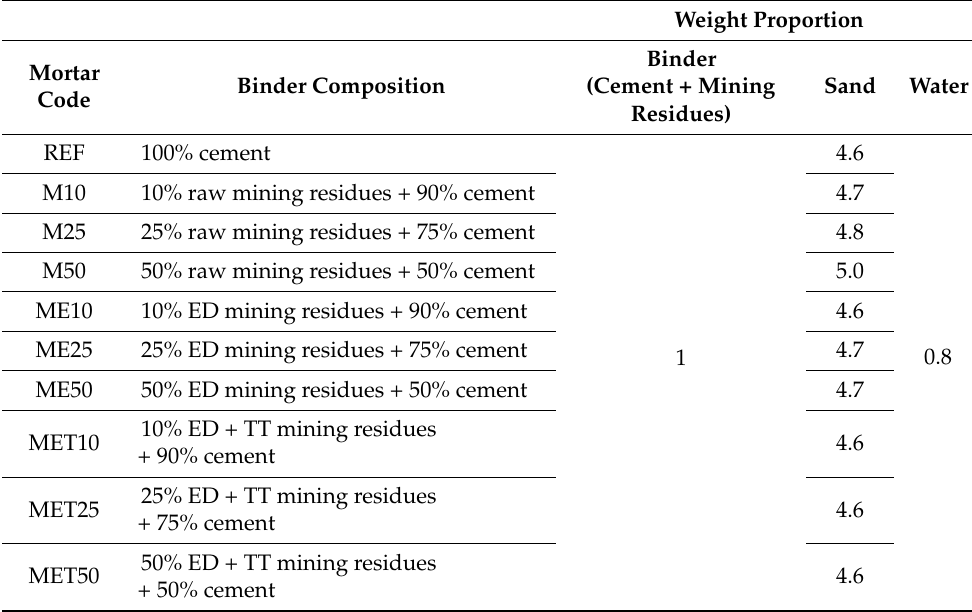
Weight Proportion